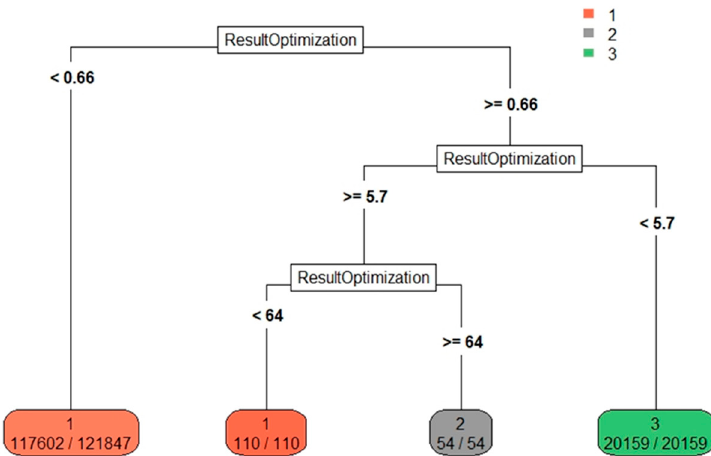
Figure 7. Decision tree. Results for the whole week scenario.